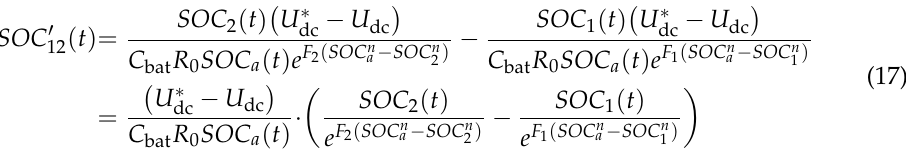
s Figure 7. Equivalent model for stability analysis. From Figure 7 above, the following equation can be obtained: { 𝑈 dc𝑖 (𝑠) = 𝑈 dc∗ − 𝑅 SOC𝑖